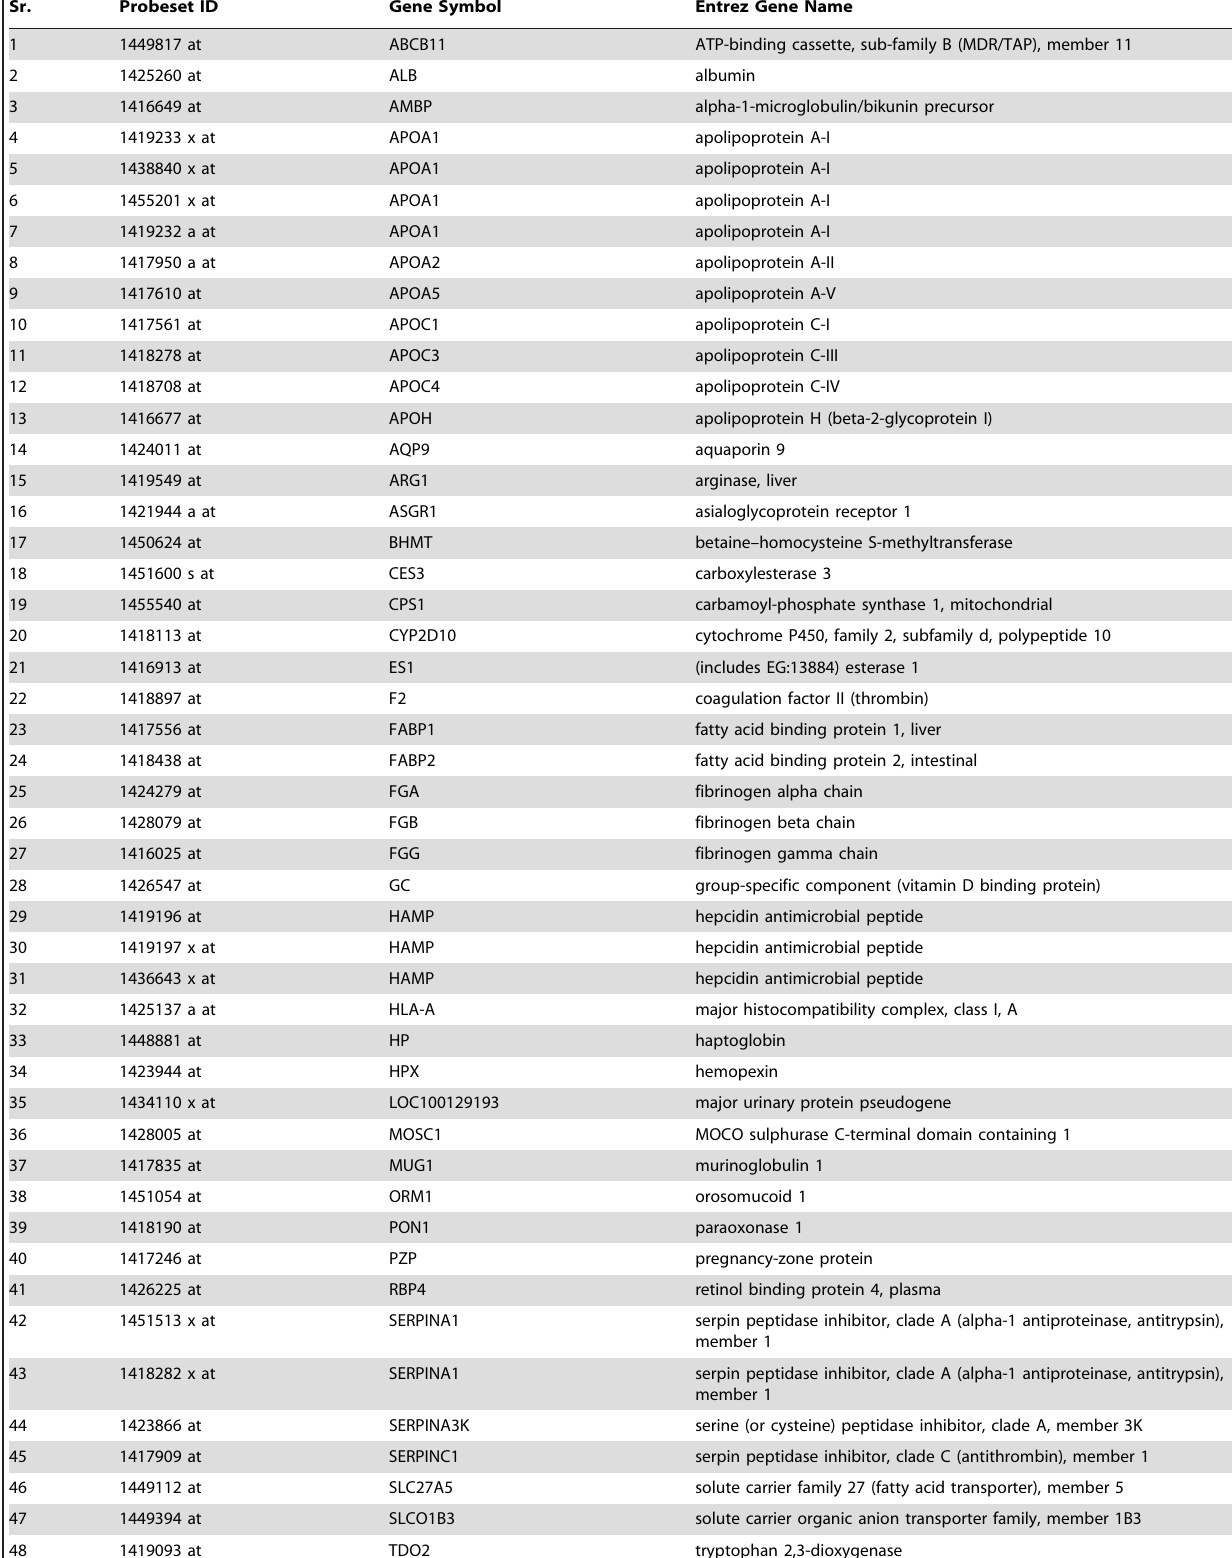
Table 14. Liver 1 heart 4 cluster 2.